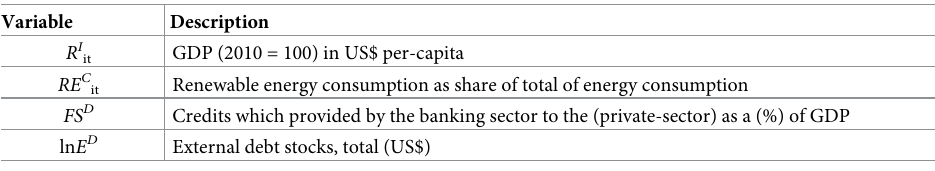
Table 2. Description of investigated